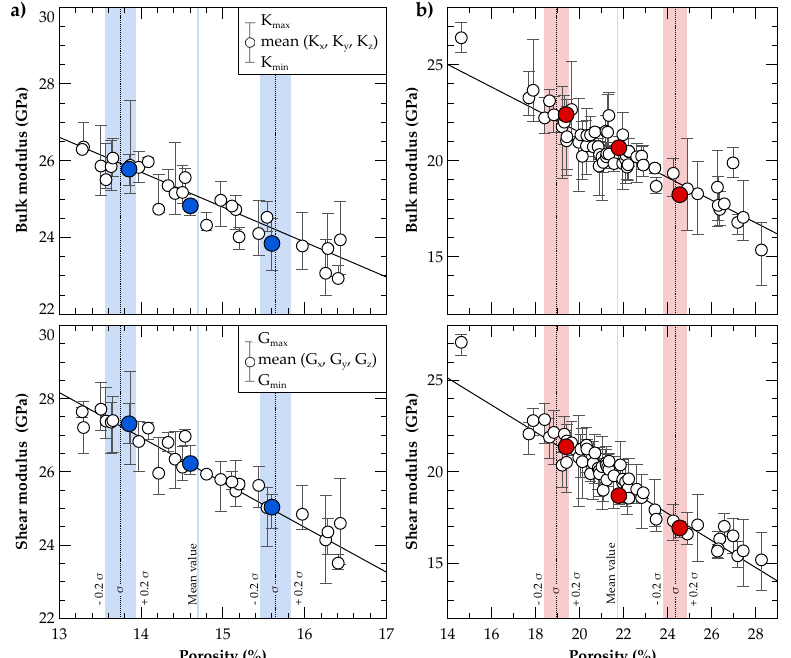
Figure 7. Bulk and shear moduli of all sub-cubes (empty circles) decrease linearly with porosity. Three representative sub-cubes (blue- and red-filled circles), which are preferably isotropic, are selected from ( a ) 30 Fontainebleau and ( b ) 60 Bentheim sandstone sub-samples. While the sub-volumes of the Fontainebleau sample have a relatively narrow porosity spectrum (blue lines), the range for the Bentheim sandstone porosity (red lines) is substantially